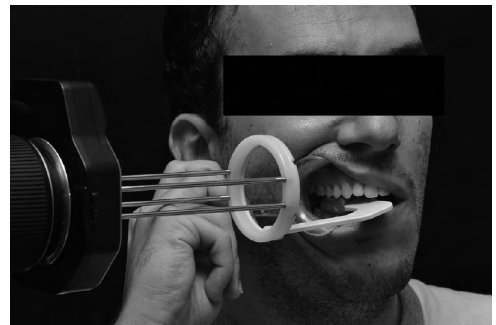
Figure 2. View of the standardizing device/radiographic positioner with occlusal registration coupled to the camera lens to standardize the angle, focal length and framing. The occlusal registration (Pattern Resin LS, GC America) was made over the positioner, not compromising the area to be